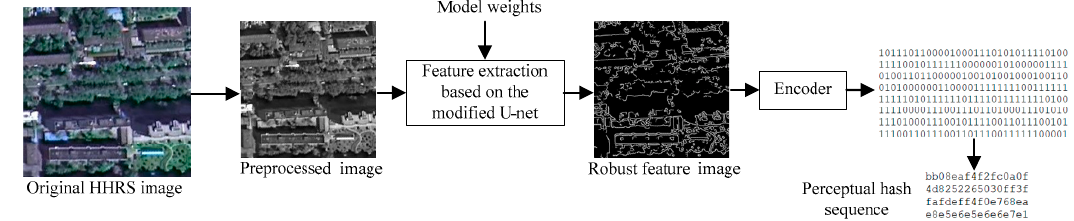
Figure 7. An example of the perceptual hash sequence generation (without encryption).